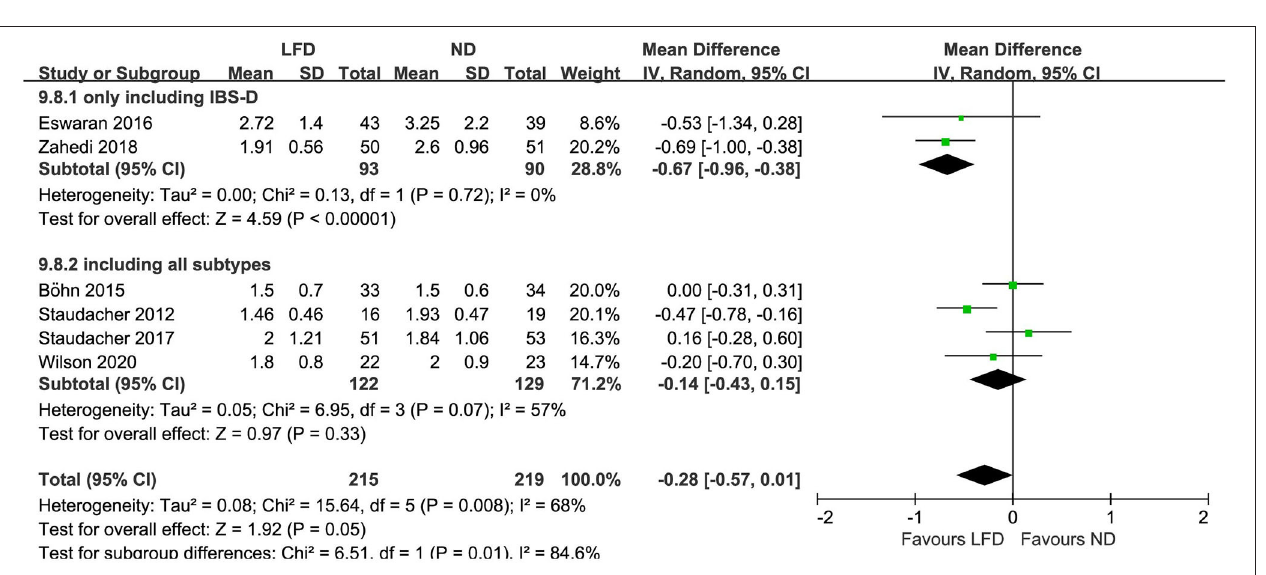
FIGURE 5 | Pooled mean difference for stool frequency (per day). LFD, low-FODMAP diet; ND, normal